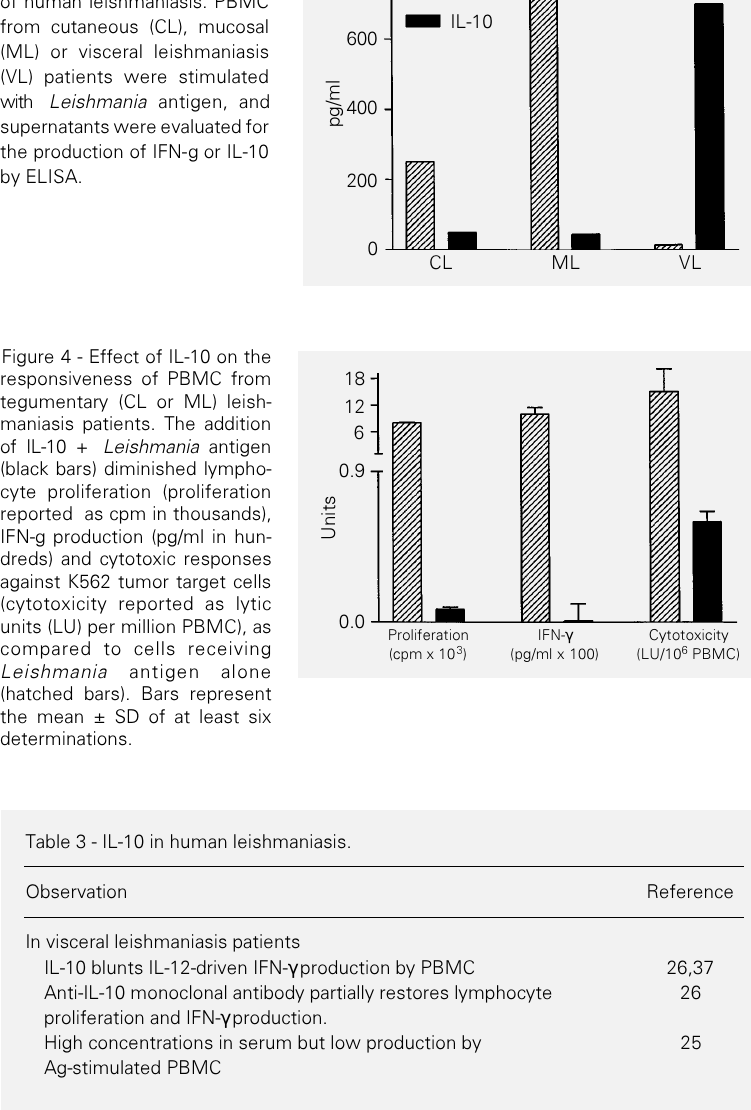
VLFigure 3 - Production of IFN-g or IL-10 in different clinical forms of human leishmaniasis. PBMC from cutaneous (CL), mucosal (ML) or visceral leishmaniasis (VL) patients were stimulated with Leishmania antigen, and supernatants were evaluated for the production of IFN-g or IL-10 by ELISA.